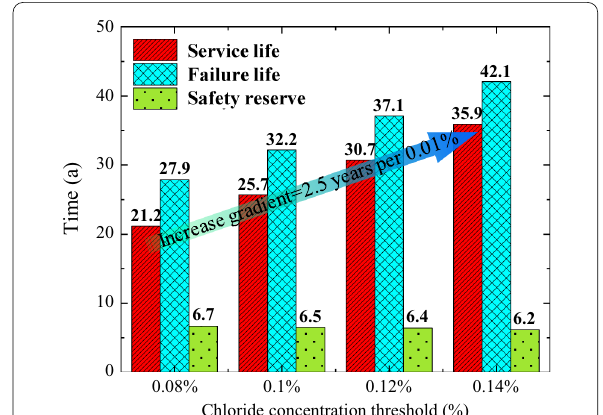
Fig. 8 Effect of critical chloride ion concentration on service